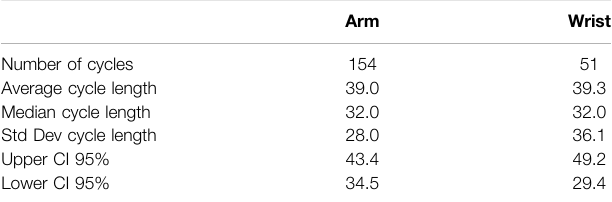
TABLE 6 | Cycle comparison by skin site